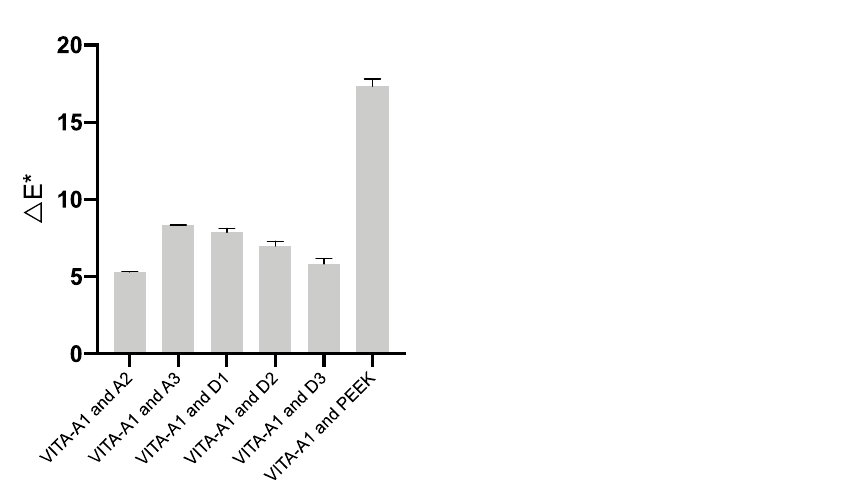
Figure 9. The color difference between PEEK specimens and dental shade.